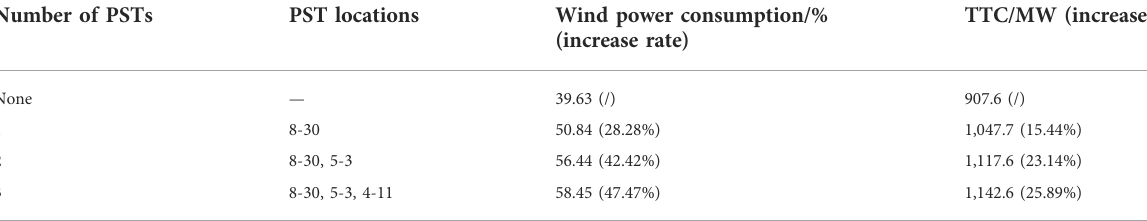
TABLE 6 IEEE 118-bus system results for various numbers of PSTs.